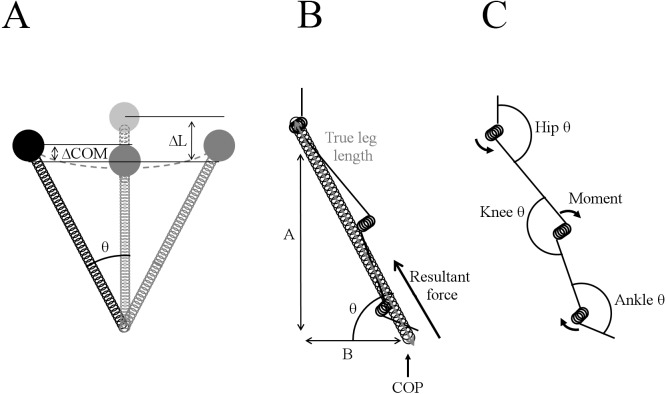
Biomechanical stiffness models.(A) McMahon & Cheng’s (1990) spring-mass model for vertical and leg stiffness (McMahon & Cheng, 1990); (B) Coleman et al. (2012) true leg stiffness model; (C) joint stiffness model (Blickhan, 1989; Farley & Morgenroth, 1999).